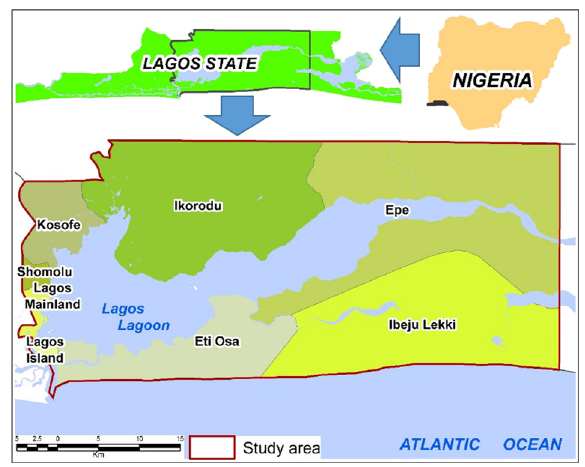
Fig. 1. Map showing the study area.